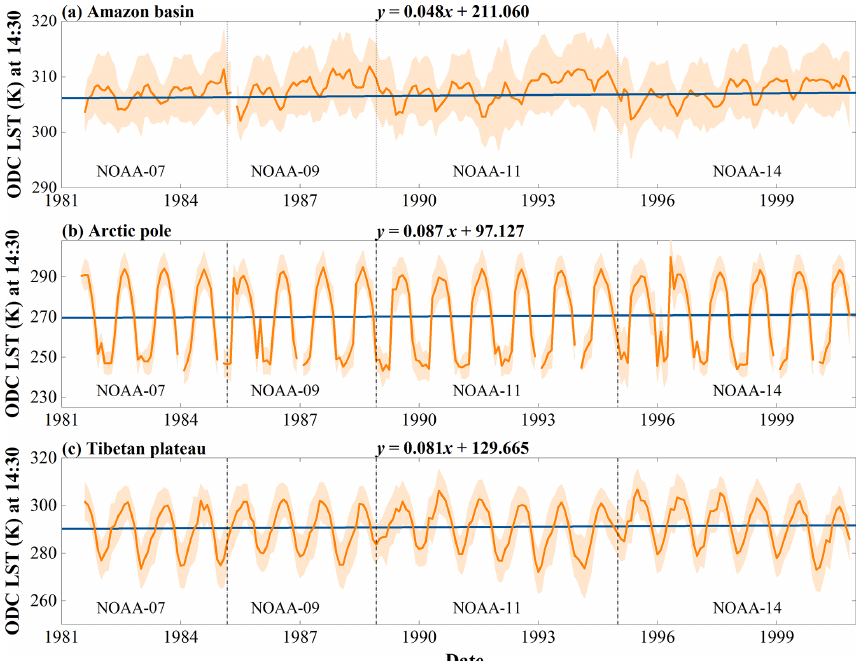
Figure 12. Monthly averaged ODC LST time series normalized to 14:30ST for 1981–2000 over the Amazon basin (a) , the north pole (b) , and the Tibetan Plateau (c)